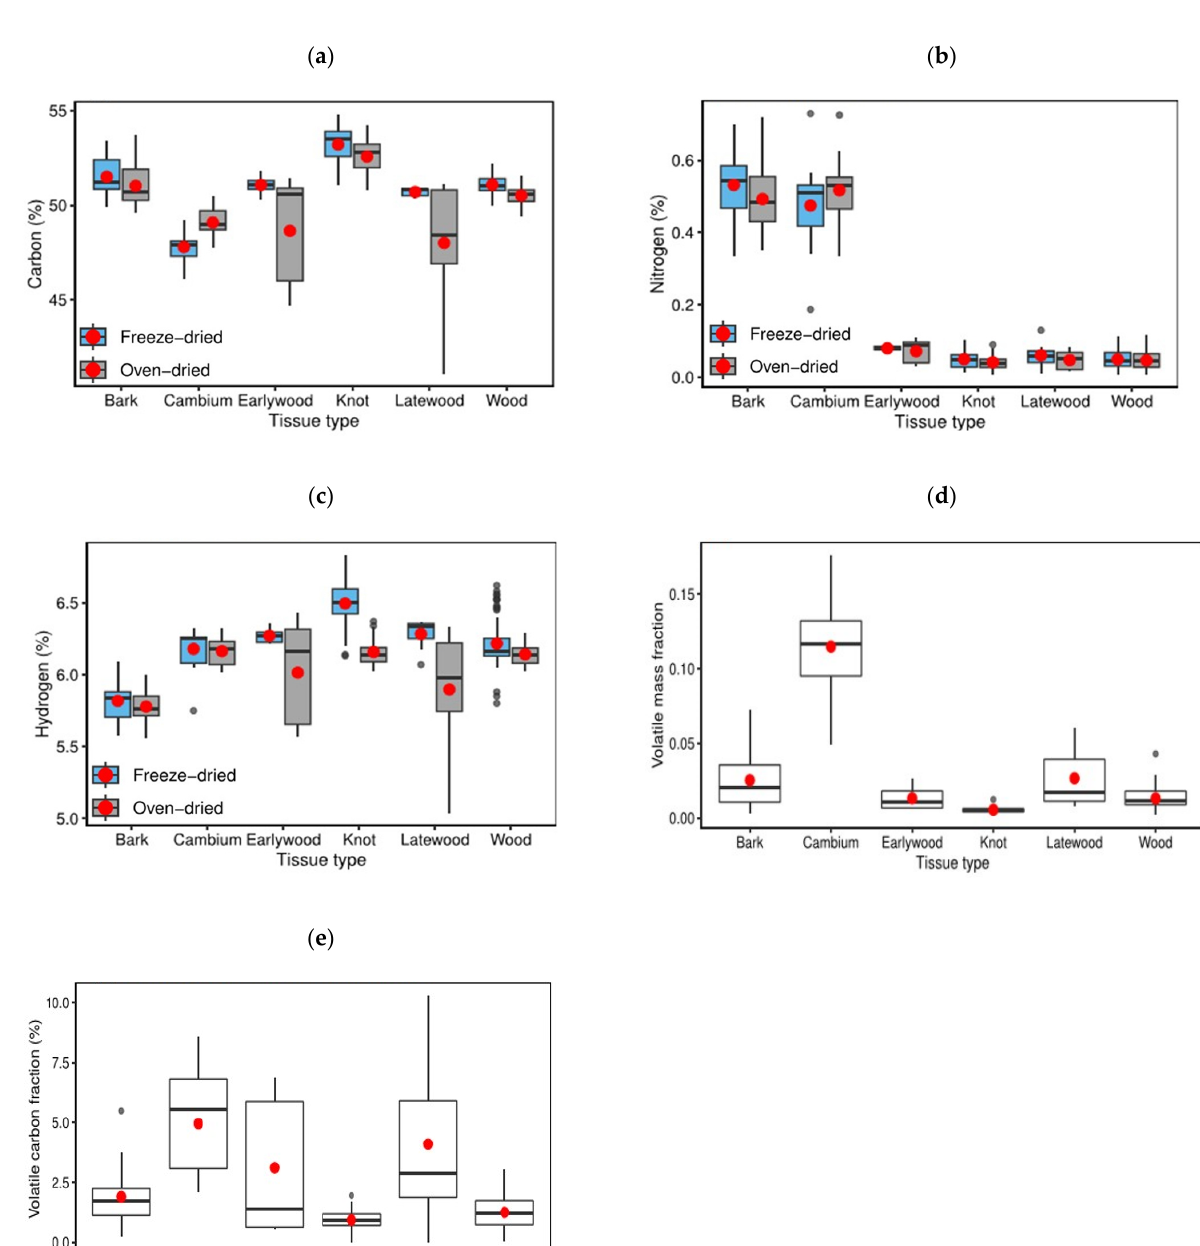
Figure 2. Box plot showing the chemical composition in different tissues of white spruce. In the plots, ( a ) denotes carbon, ( b ) nitrogen, ( c ) hydrogen, ( d ) volatile mass fraction and ( e ) volatile carbon fraction. Each plot’s upper and lower parts are the maximum and minimum values, respectively. The median is represented by a horizontal black bar. The red dots indicate the mean value.